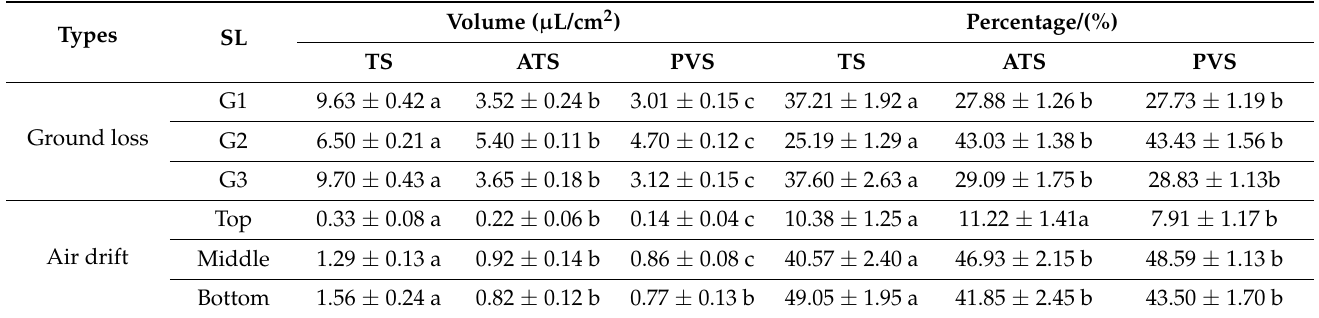
Table 7. Ground loss and drift at different locations evaluated in the test. The data in the table were obtained through SPSS. SEM was used to represent the deviation of the data in the